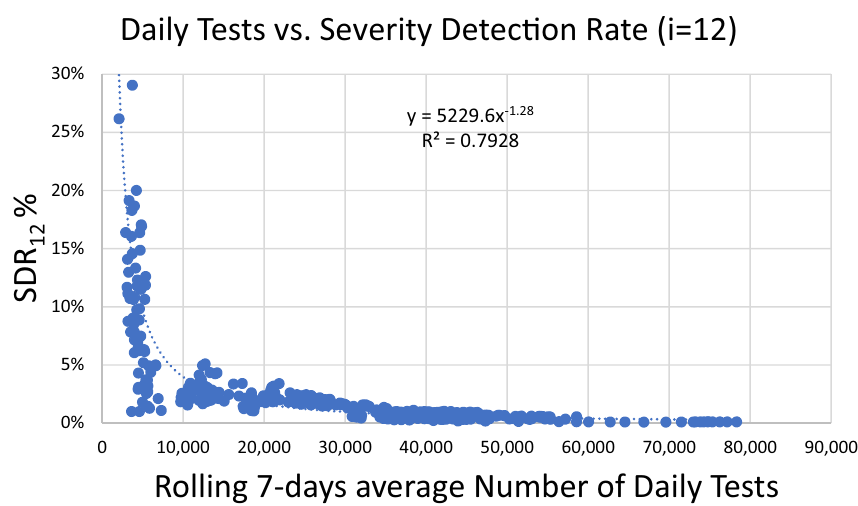
Figure 2. Correlation between the Severity Detection Rate and rolling 7-day averages of the number of daily tests, with Spearman r = − 0.90, p = 10 −167 , N = 451. Numbers of daily tests derived from the period from 15/5/2020 to